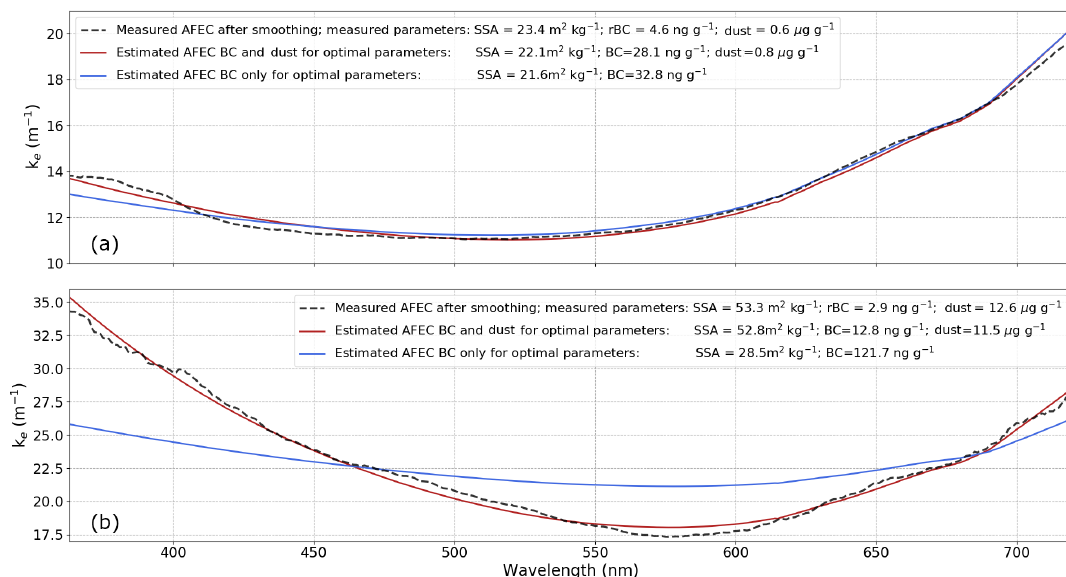
Figure 12. AFEC measured (black dotted line) and estimated considering both dust and BC (red curves) or considering only BC (blue curves) in the retrieval algorithm. (a) On a ZOI located between 11 and 14cm on the SOLEXS profile 002 measured on 23 February 2018, where LAP absorption is dominated by BC. (b) On a ZOI located between 33 and 36cm on the SOLEXS profile 004 measured on 1 October 2018, where LAP absorption is dominated by dust (around 10µgg − 1 of dust measured).